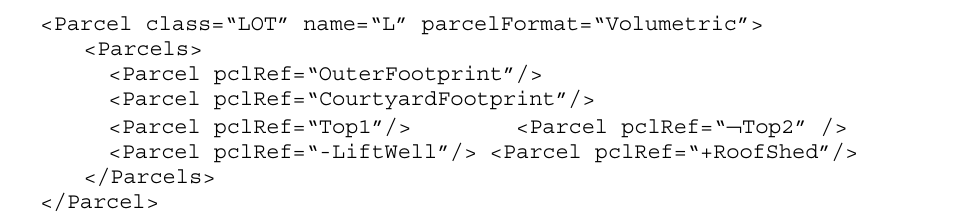
Figure 12. Note that the roof shed overlaps and partially blocks the CourtyardFootprint and LiftWell.